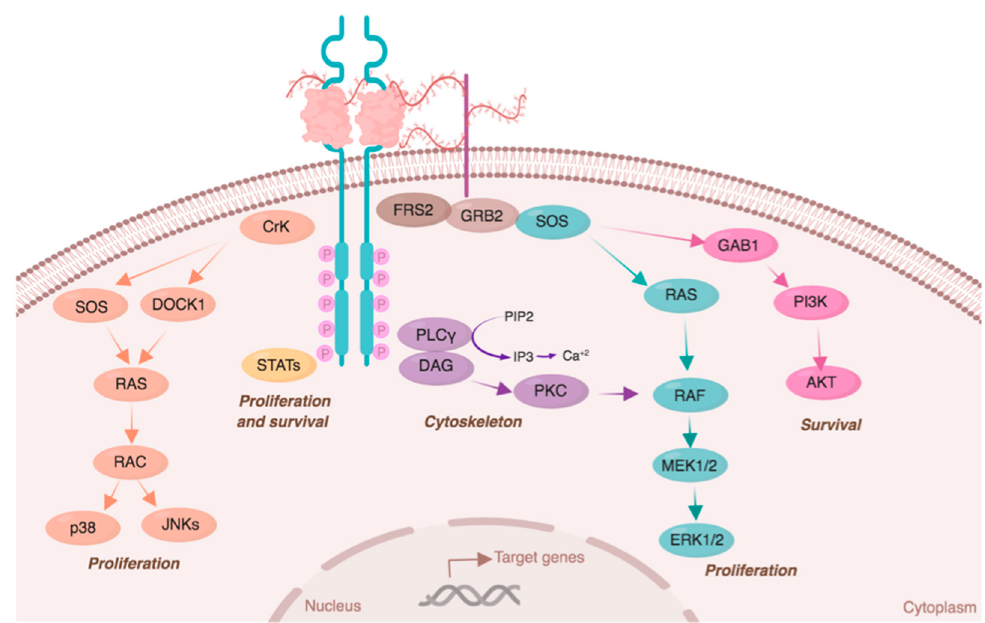
Figure 3. FGFR signaling pathway. After ligand binding, FGFRs dimerize and activate multiple signal transduction pathways. Each pathway induces the expression of specific target genes related to cell proliferation (STATs, RAS/p38/JNKs, and RAS/MAPK/ERK), survival (STATs and PI3K/AKT), and cytoskeleton regulation (PLC/Ca 2+ ). Kinases are color-coded according to their specific signaling pathway. Image created with biorender.com.